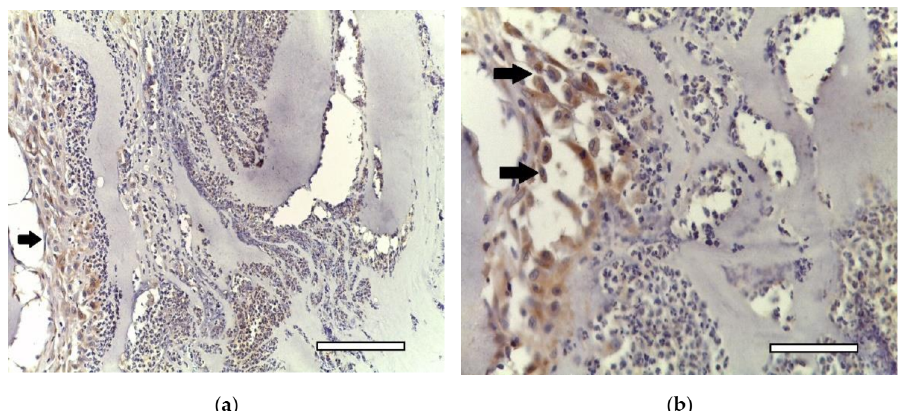
Figure 17. 2nd group (MSC only), 2 weeks. Connective tissue capsule (arrows). Collagen type II staining. Macrophages with cytoplasm stained for type 2 collagen. ( a ) objective lens × 20, scale